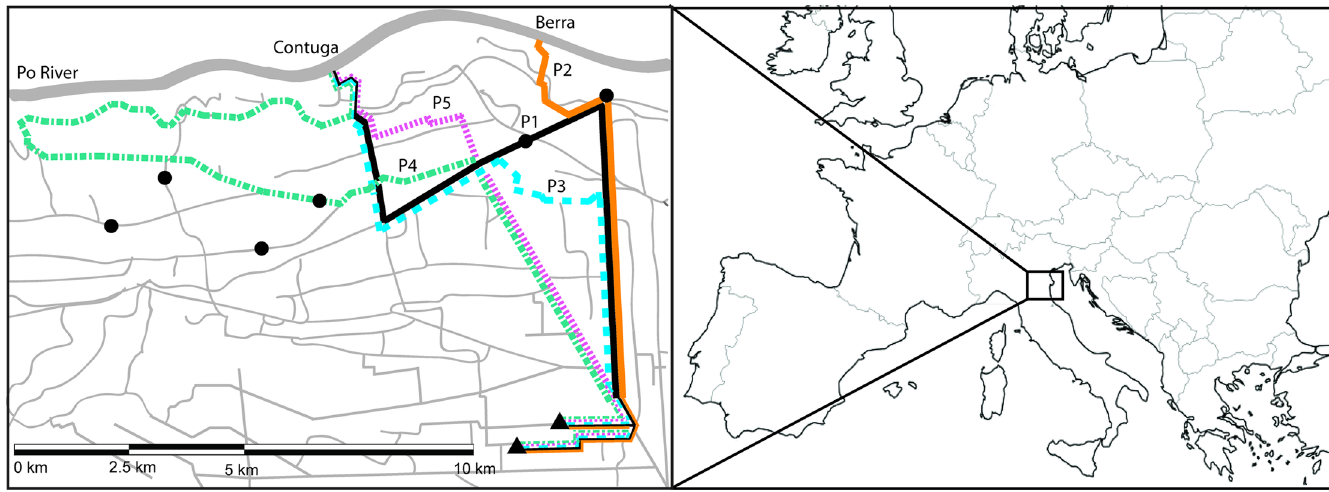
Fig 1. Schematic representations of five potential egg pathways within the canal network. Po River, at the top of the map, and canals of the network are presentedwith solid grey lines. Solid and dashedcolor lines represent available pathways from the Contuga(P1, in solid black, and P3–P5, in blue long dashes, green dash and dots and pink short dashes, respectively)and Berra (P2, in solid orangeline) siphoningstations to the locationswhere YOY individualswere captured, representedwith black triangles. Sampling locations of adult bigheadcarp are representedwith black circles.